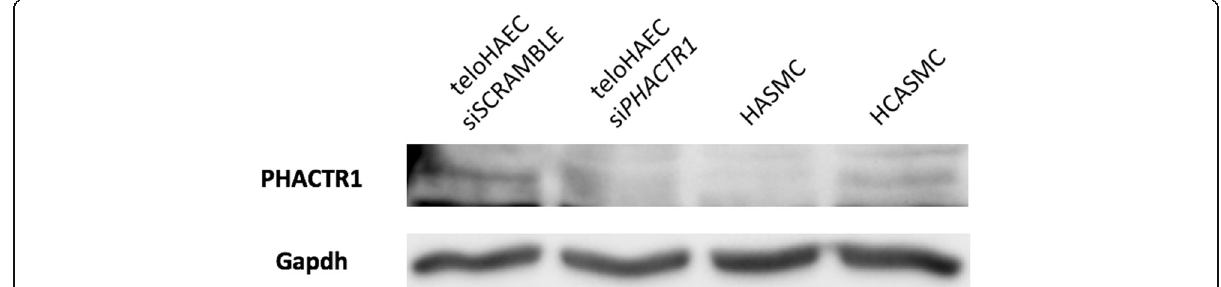
Fig. 3 Presence of PHACTR1 protein in vascular smooth muscle cells. We tested for the presence of the PHACTR1 protein by immunoblotting using a custom anti-PHACTR1 antibody. The first and second lane, using teloHAEC protein extracts treated or not with a short interfering RNA (siRNA) against PHACTR1 , serve as control to demonstrate the specificity of this anti-PHACTR1 antibody. Although we did not detect PHACTR1 in human aortic smooth muscle cells (HASMC), there is weak but specific band corresponding to PHACTR1 in human coronary artery smooth muscle cells (HCASMC). The expected 64 kDa PHACTR1 protein migrated with an apparent molecular weight of 74 kDa. GAPDH was used as loading control